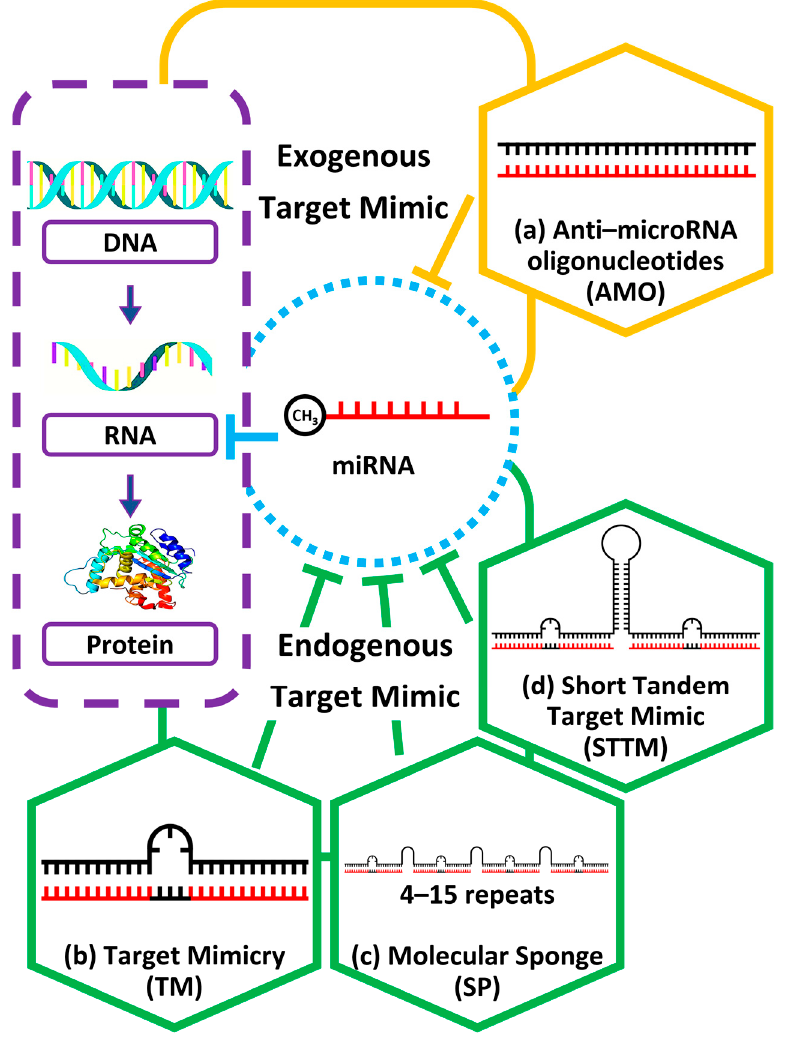
Figure 1. Exogenous mimicking approaches by using ( a ) anti–microRNA oligonucleotides (AMO) while endogenous approaches include ( b ) target mimicry (TM), ( c ) molecular sponges (SP) and ( d ) short tandem target mimic (STTM). The mechanism used to mimic the miRNA varies from its secondary structure and the number of miRNA binding sites.